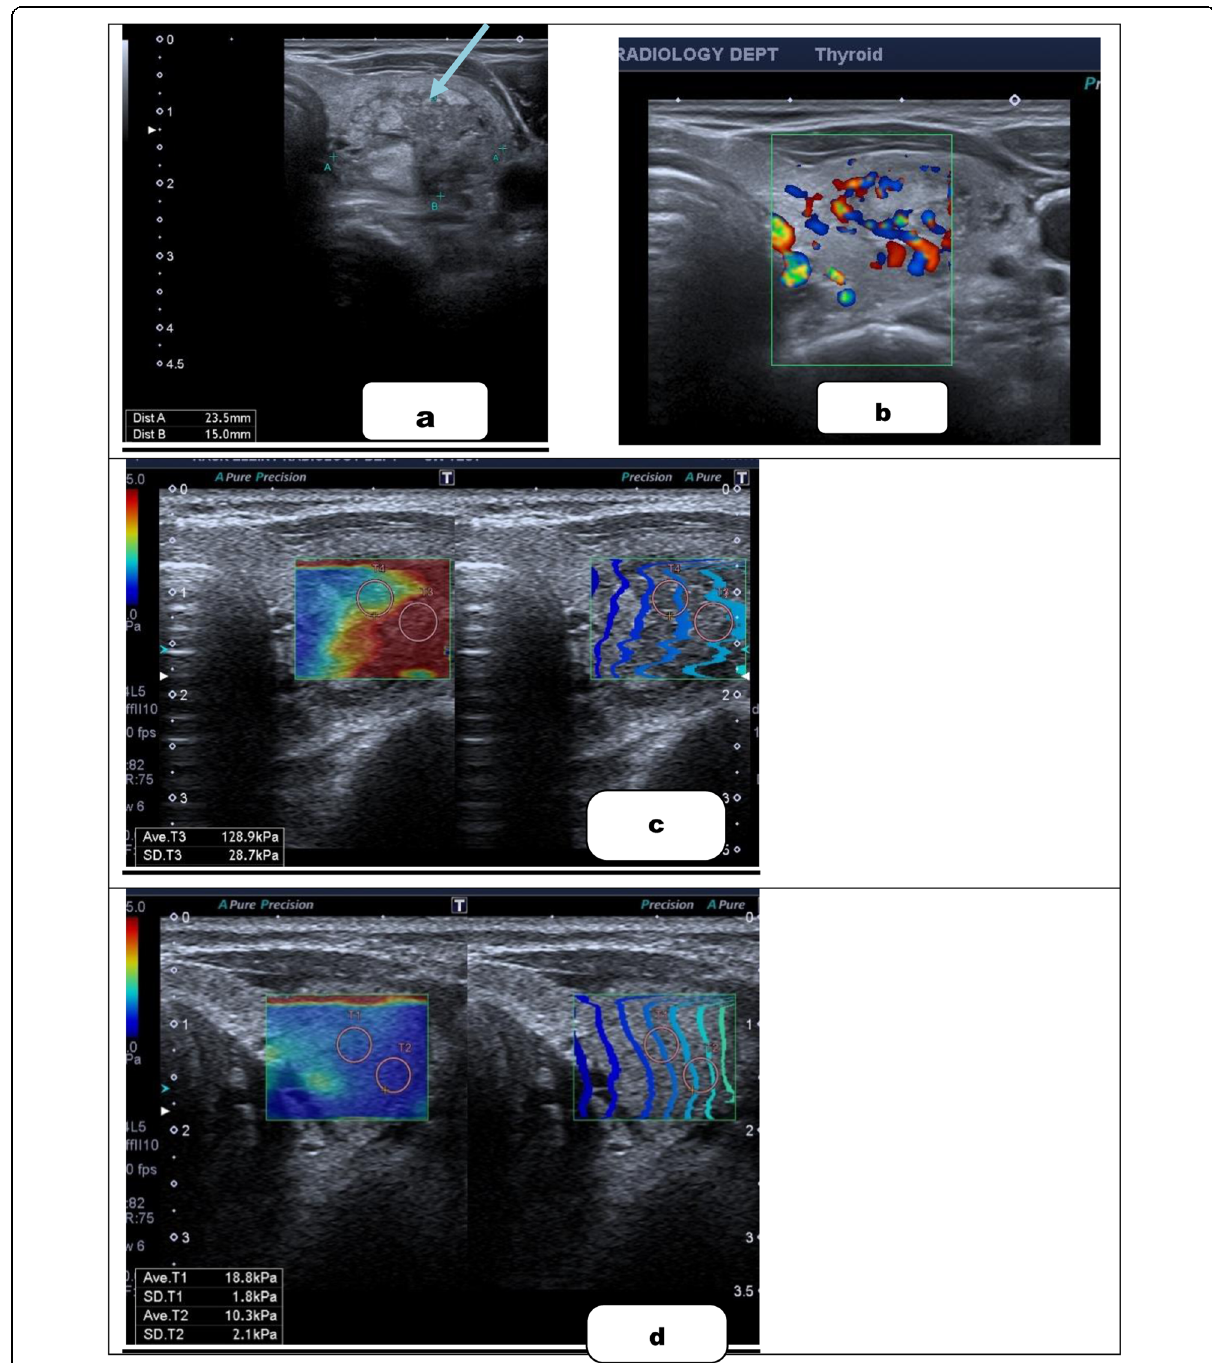
Fig. 7 Ultrasound images for a 53-year-old male patient. a Axial ultrasound B-mode image is showing heterogeneous left solid thyroid nodules that are hypo to isoechoic with punctuate and macro calcification (TI-RADS 4) (arrow). b Axial color image is showing both peripheral and internal vascularity (1c). c Axial shear wave elastography of the thyroid nodule ( E mean = 128.9 kPa and ER = 6.8). d Axial SWE of the normal right thyroid parenchyma; the FNAC revealed malignant cells with psammomatous calcification (Bethesda 5), and the post total thyroidectomy histopathological examination had confirmed the presence of medullary thyroid